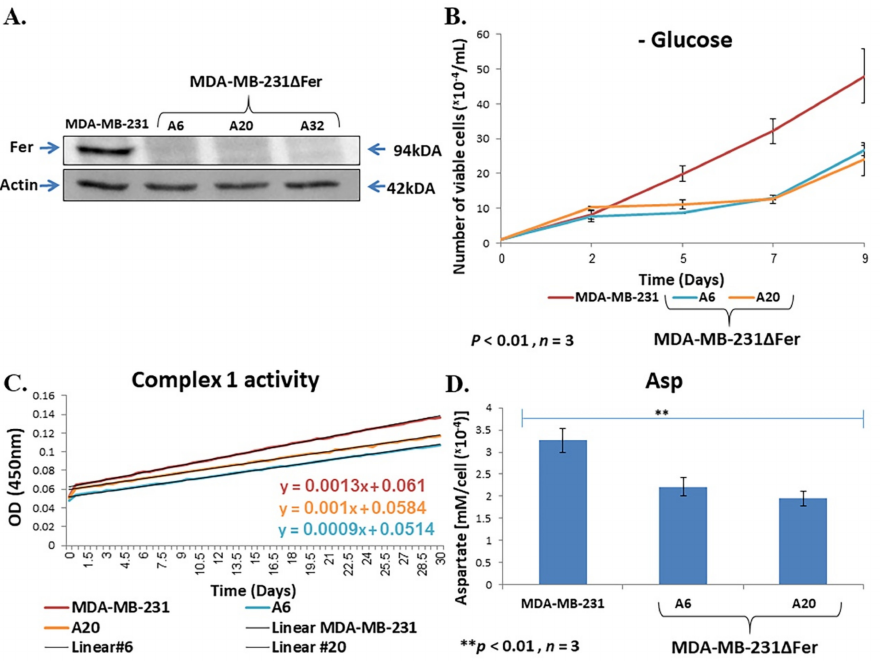
Figure 5. Fer sustains metabolic plasticity and mitochondrial homeostasis in MDA-MB-231 cells. ( A ) WB analysis of Fer level in MDA-MB-231 cells and in Fer-deficient MDA-MB-231 ∆ Fer clones, A6, A20 and A32. Actin served as a loading control. ( B ) Growth curves of MDA-MB-231 and MDA-MB-231 ∆ Fer cells grown in glucose-free medium, supplemented with glutamine. Values shown represent means +/ − SE ( n = 3). ( C ) Impaired comp. I activity in MDA-MB-231 ∆ Fer cells. Mitochondrial OXPHOS comp. I (NADH dehydrogenase) enzymatic activity in the parental and the Fer-deficient clones. Results are presented as absorbance at OD 450 nm over time. These results represent one out of three independent experiments which gave similar results. ( D ) Reverse HPLC analysis of aspartate levels in MDA-MB-231 and MDA-MB- 231 ∆ Fer cells. Histograms represent means +/ − SE ( n = 3). ** p -value <